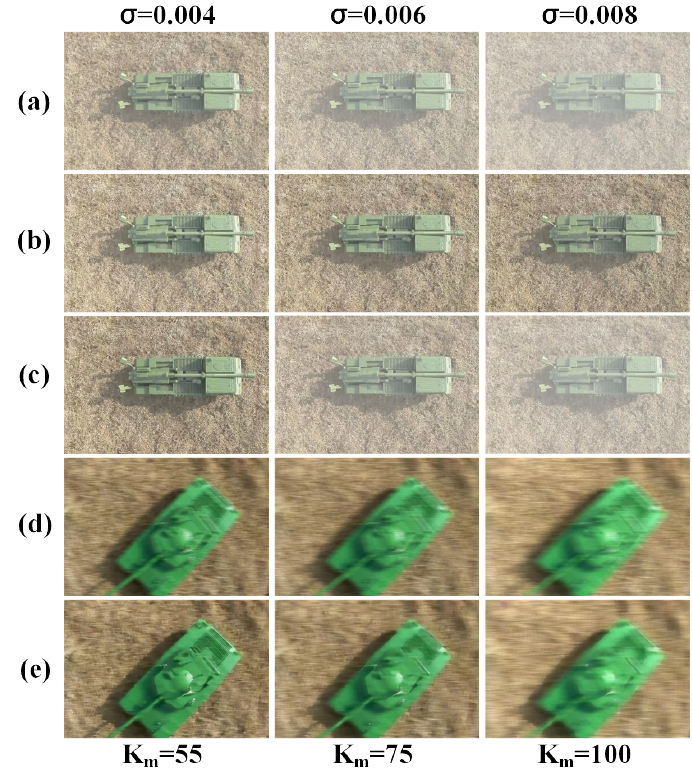
Figure 14. Pre-processed blurred images. ( a , d ) are the fog-blurred and motion-blurred images, ( b , c ) are the pre-processed images by the homomorphic filter [21] and FFA-Net [22] respectively, and ( e ) are the de-blurred images by DeblurGAN